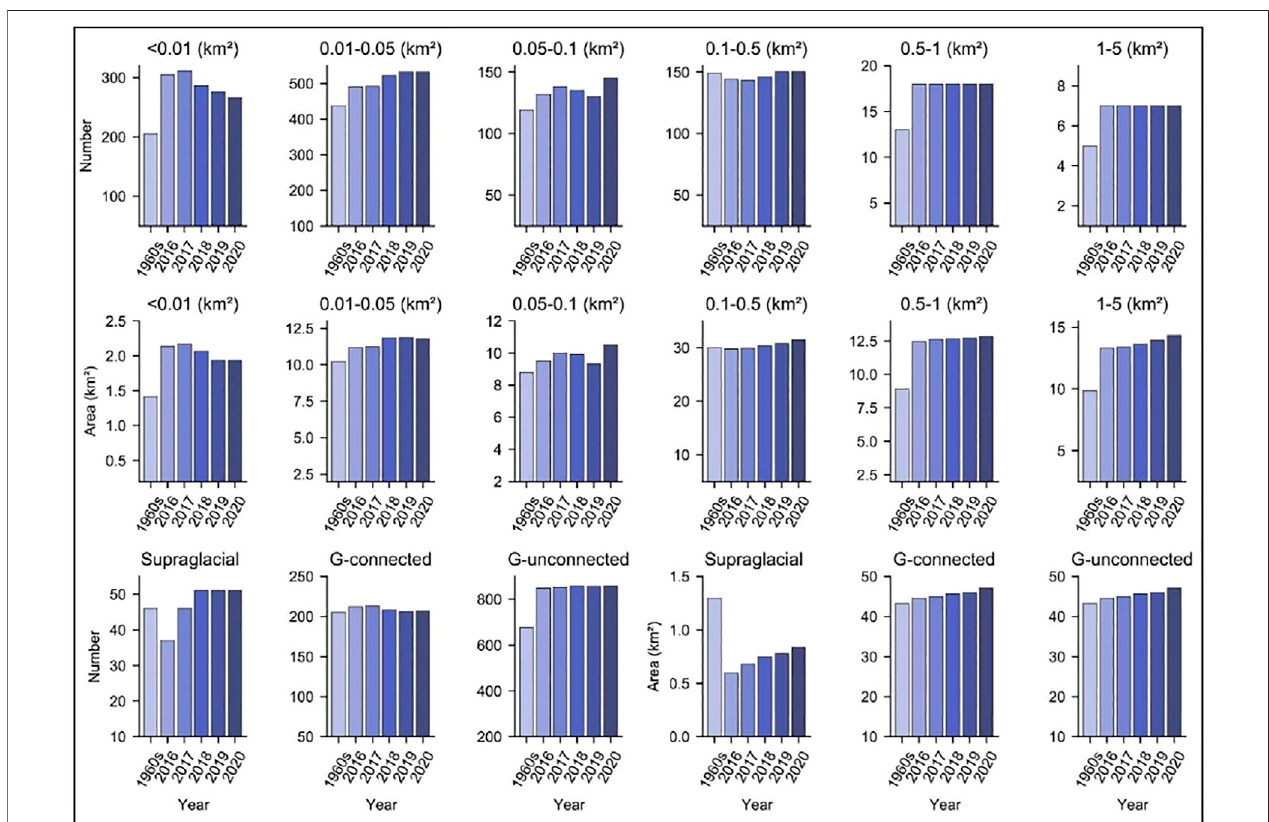
FIGURE 6 | Glacial lake (number and area) change based on different size categories and types for 1960s − 2016 and 2016 – 2020.